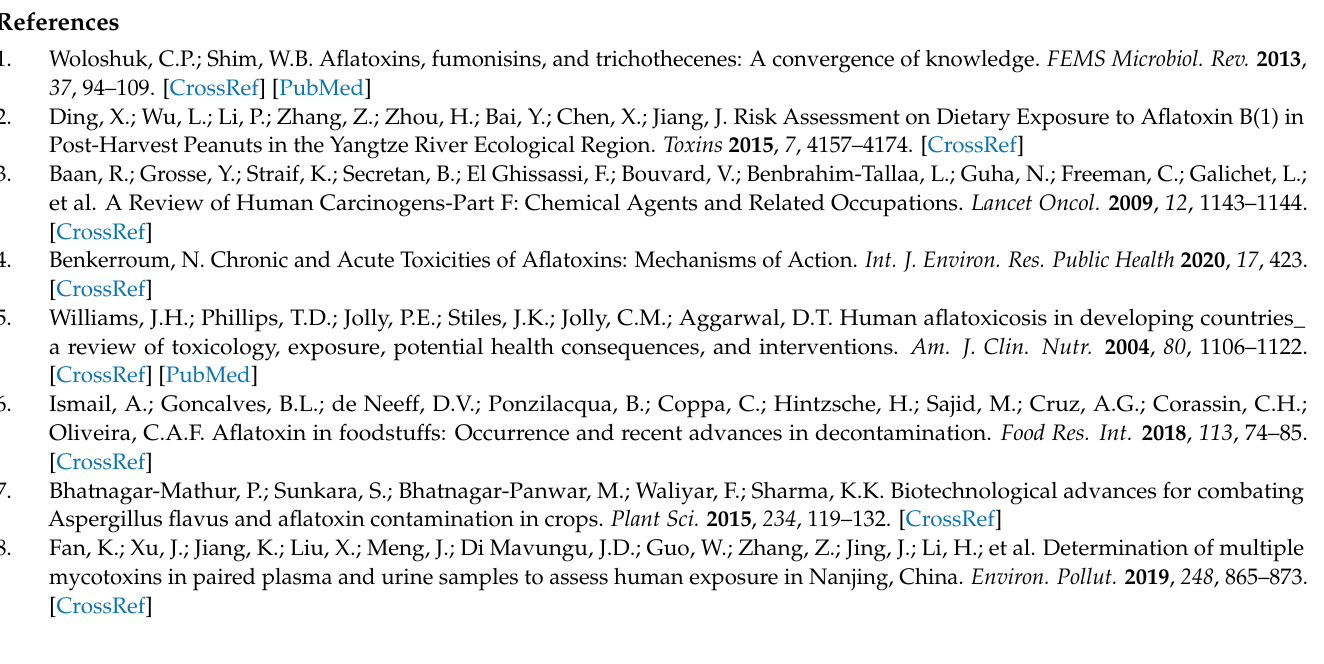
Figure S2: Flow chart of literature retrieval about aflatoxin contaminate; Figure S3: The main interface of the DALY calculator; Figure S4: Correlation between the AFTs positive rate and the total number of test samples; Figure S5: DALY of HCC associated with AFTs exposure from peanuts, peanut oil, corn, and corn products; Table S1: Retrieval strategies and results about aflatoxins in China in 2010–2020; Table S2: Relevant information of aflatoxin contaminate in peanuts; Table S3: Relevant information of aflatoxin contaminate in peanut oil; Table S4: Relevant information of aflatoxin contaminate in corn and corn product. (References [2,14,40,42,46–88] are cited in the supplementary materials). Author Contributions: Conceptualization, T.C. and S.W.; methodology, T.C.; software, T.C.;